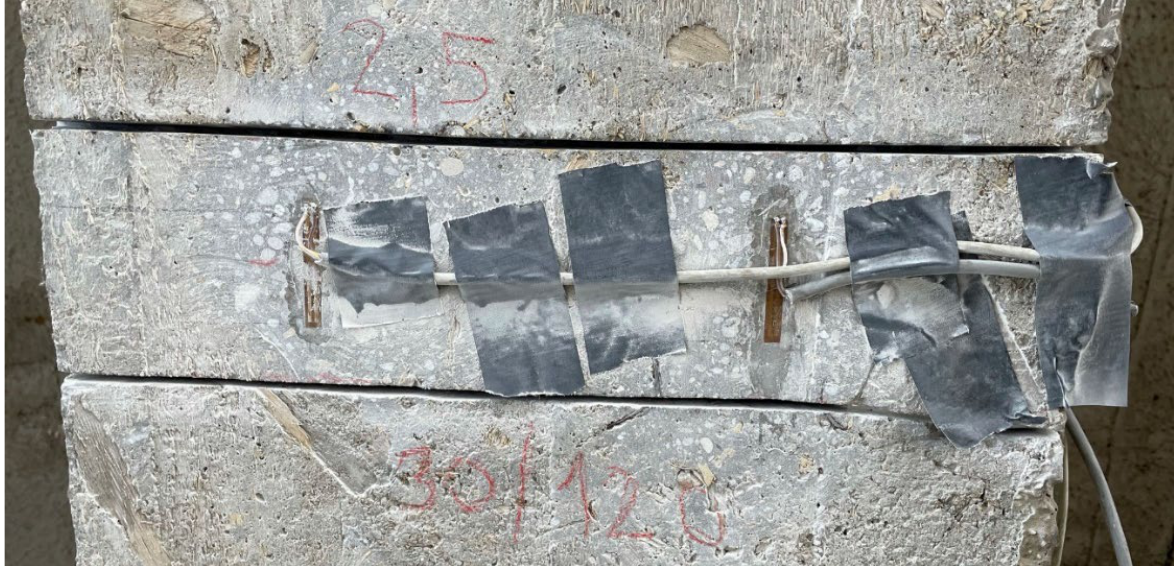
Materials 2022 , 15 , x FOR PEER REVIEW Figure 9. Position of performed saw-cuts and their parameters (dimensions are in [mm]).